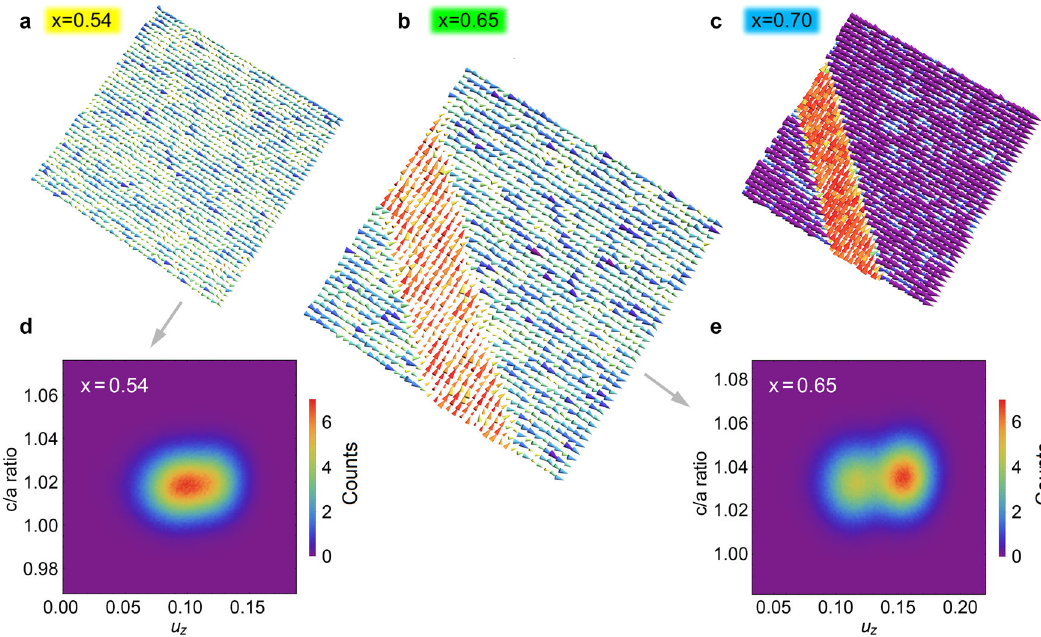
Fig. 5 Monte Carlo simulated domain structure evolution near x T at room temperature. a Nesting tetragonal and monoclinic nanodomains induced by tcr second-order transition in x < x T PZT. b Hierarchical domain structure induced by frustrated-order transition in x = x T PZT. c Ferroelastic 90° domain tcr tcr structure induced by fi rst-order transition in x > x T tcr PZT. The local electric dipoles are colored according to their projection on the [010] p direction while the arrowhead size indicates the magnitude of the electric dipole. The supercells (40 × 40 × 5 pseudocubic unit cells) are viewed along the [001] p direction. d , e Joint probability distribution of local mode ( u z ) and local tetragonality for d x = 0.54 and e either c or a domain of x = 0.65 PZT supercells, respectively. The colors denote probability distribution in the 2D correlation